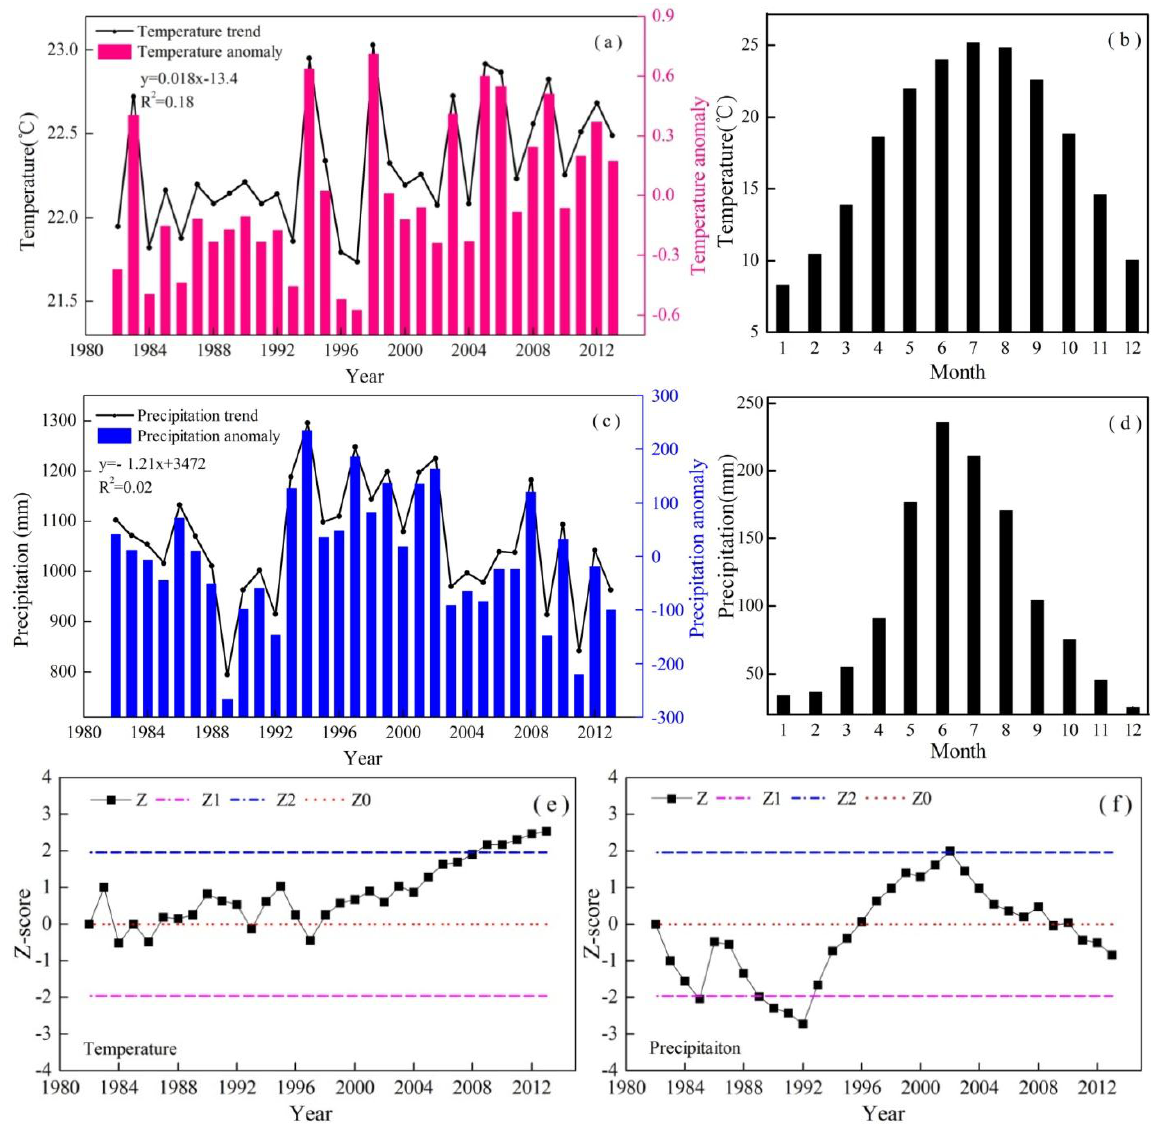
Figure 5. Interannual variations in average growing-season temperature trend and anomaly ( a ); monthly temperature ( b ); precipitation trend and anomaly ( c ); monthly precipitation ( d );